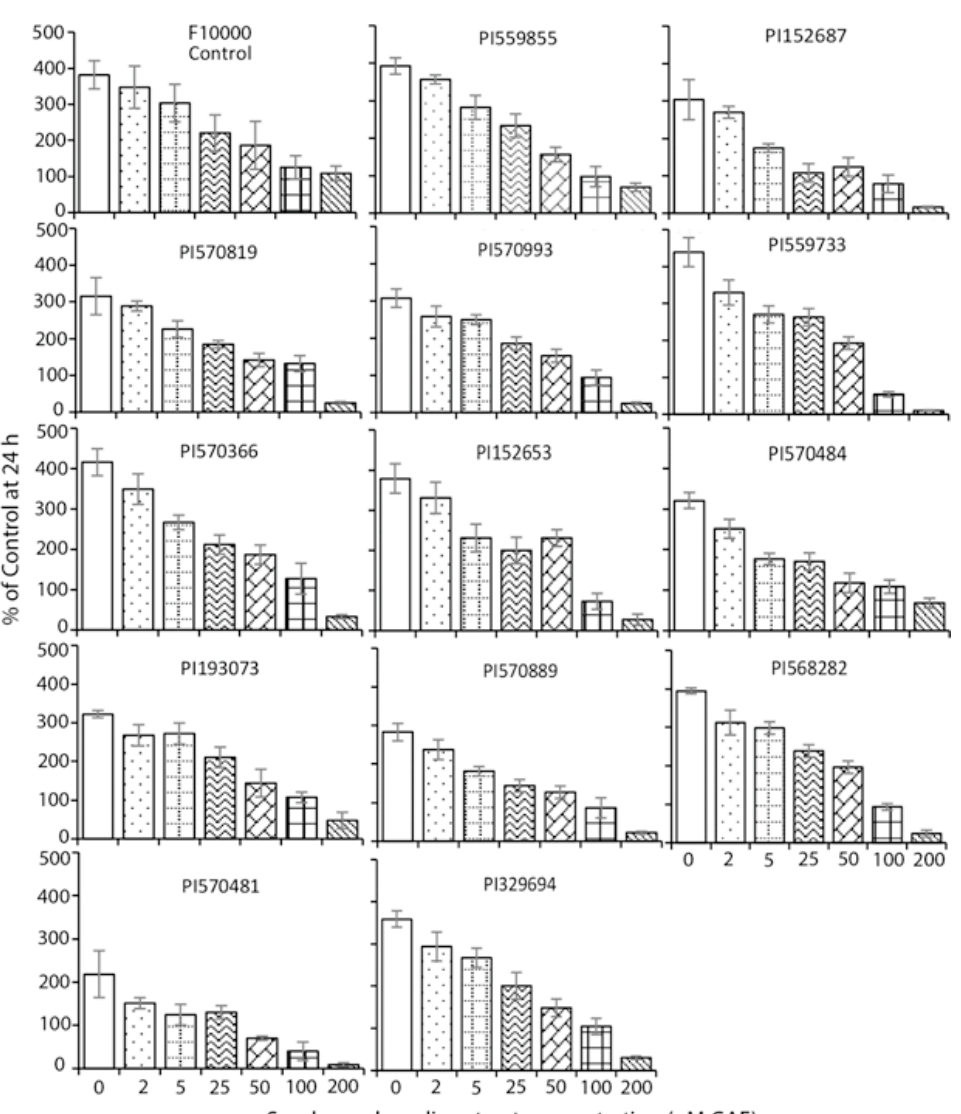
Figure 1. The effect of various sorghum phenolic extracts at 0–200 µ M GAE for up to 72 h on cell growth in HepG2 cells. HepG2 cells were cultured with phenolic extracts at various concentrations (0–200 μ M GAE) for up to 72 h in 6-well plates, then detached by trypsin-EDTA solution, and the cell number was counted by a hemacytometer. Values are expressed as Mean ± SD ( n = 3). The significance of the trend for cell growth inhibition at various concentrations was analyzed with linear regression, p < 0.05.